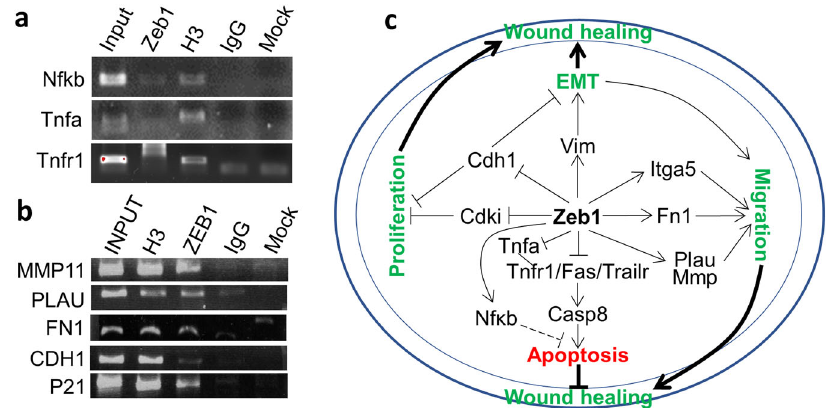
Fig. 7 ZEB1 regulates the expression of genes involving corneal epithelial wound healing. a Chromatin immunoprecipitation (ChIP) assays on the binding of mouse Zeb1 to the putative promoters of Nfkb, Tnfa , and Tnfr1 . b ChIP assays on the binding of human ZEB1 to the putative promoters of MMP1, PLAU, FN1, CDH1 , and P21 . c A schematic diagram describing the molecular mechanisms underlying Zeb1-regulation of corneal epithelial wound